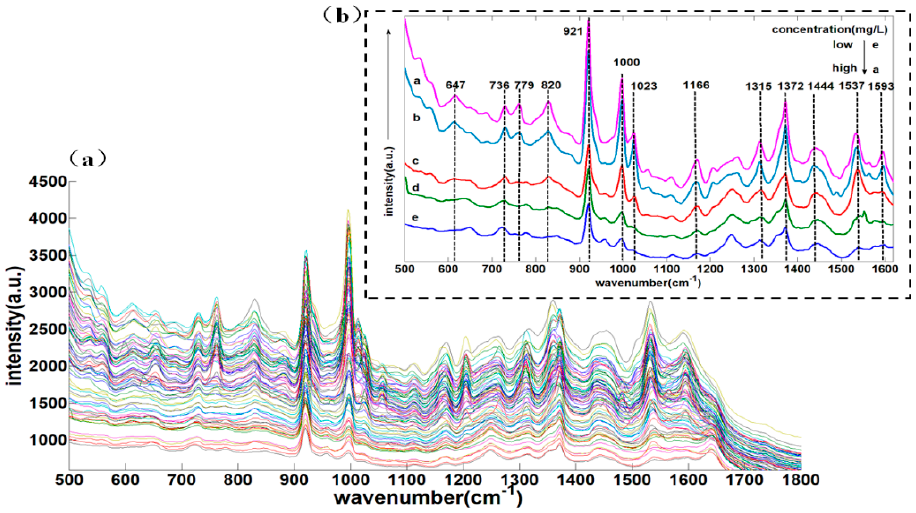
Figure 6. ( a ) 500–1800 cm − 1 SERS spectra of different concentrations of deltamethrin in strawberry; ( b ) the SERS spectra of five concentrations of deltamethrin in strawberry. Table 3. Results of pre-processing method for calibration and prediction model.